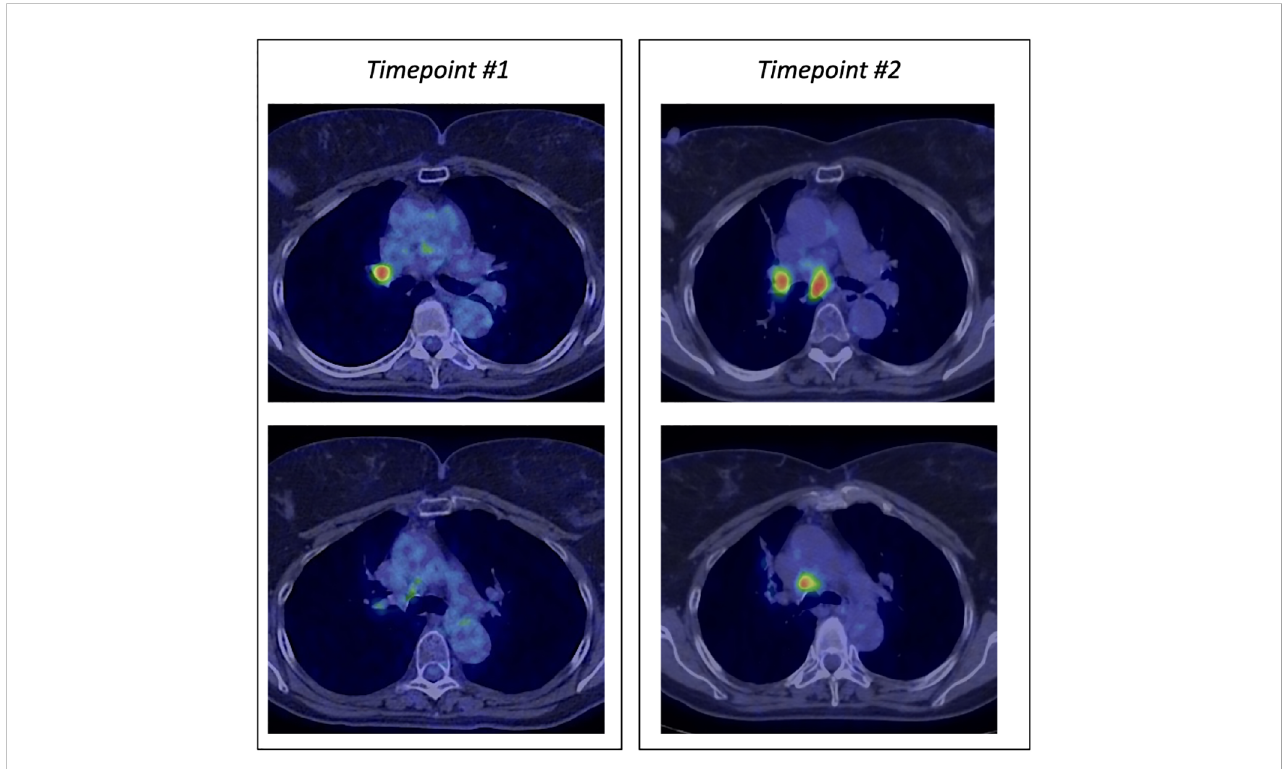
FIGURE 1 PET scan at baseline showing the progression at mediastinal lymph